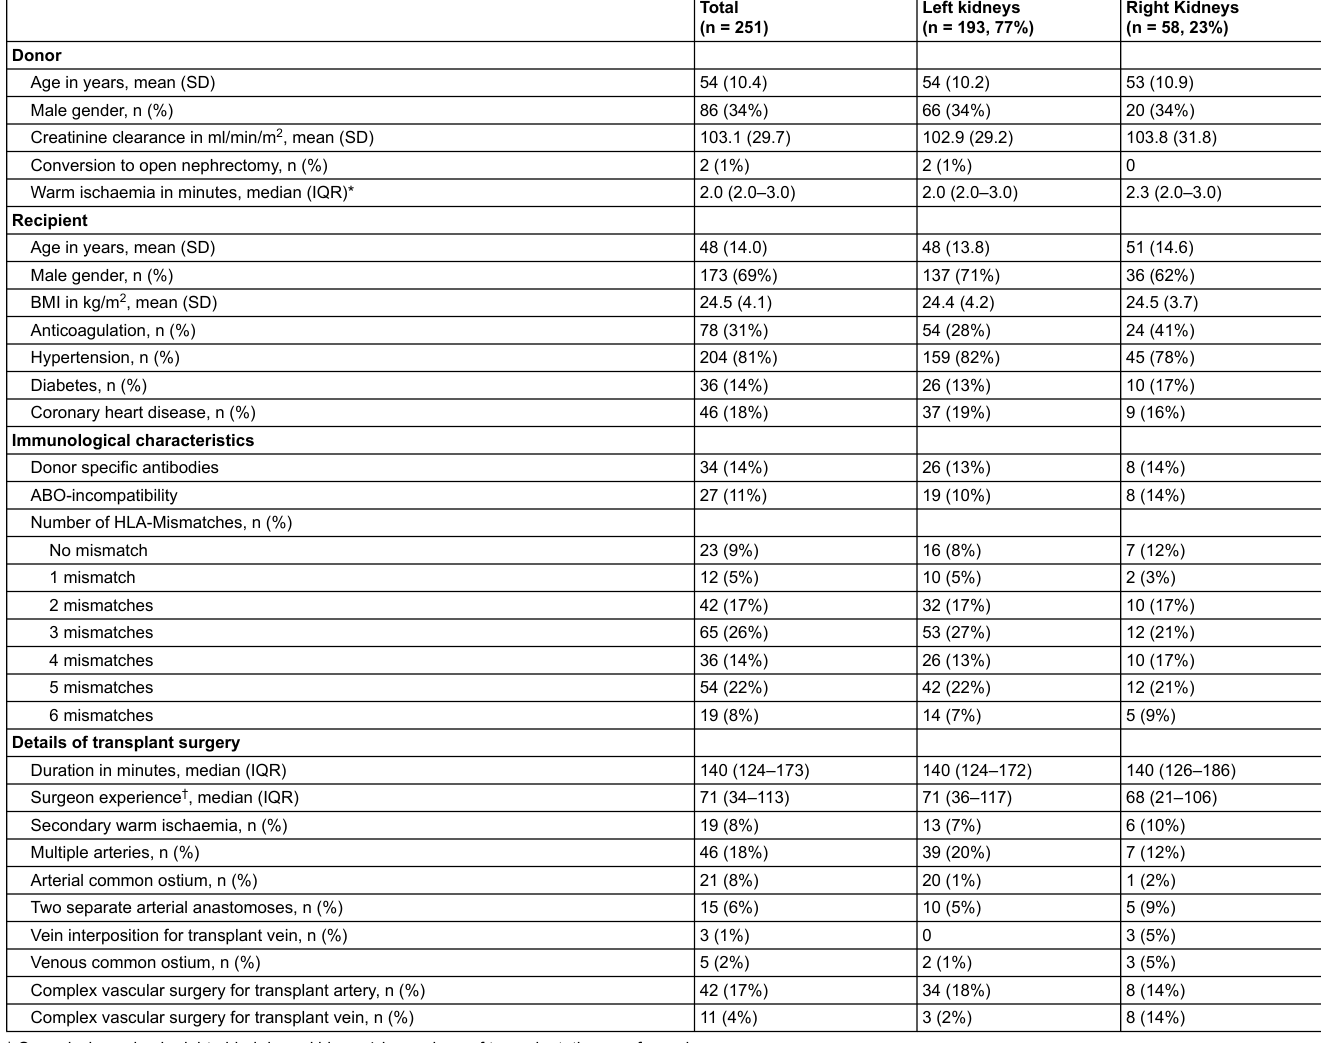
Table 1: Donor and recipient baseline characteristics and details of transplant